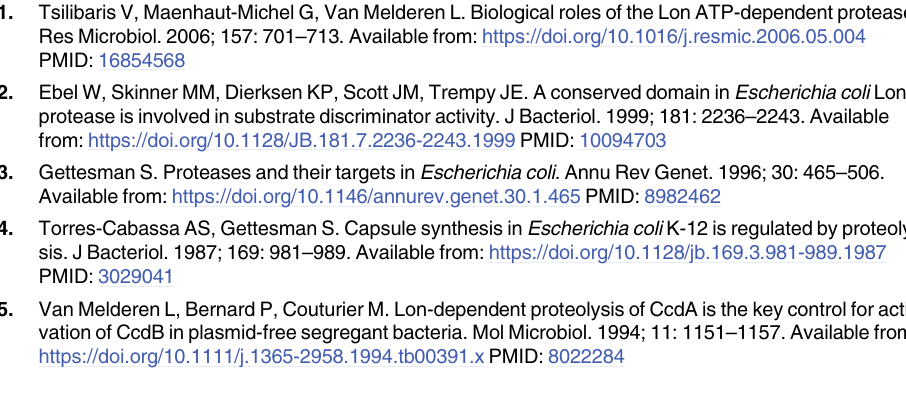
S4 Fig. Oxalate biosynthetic component activity (units per CFU). The letters (a, b, and c) above each mean represent significant differences based on a one-way analysis of variance (ANOVA), followed by Tukey’s post-hoc analysis. A value of p < 0.05 indicates significant dif- ferences among strains. S5 Fig. No detection of TofI-HA in the immunoprecipitated sample using an anti-Lon antibody. Strain S2HA carrying the TofI-HA clone, pTOFI6, was used to determine interac- tion between Lon and TofI. S6 Fig. Similarities among ATP-dependent Lon proteases of B . glumae , Pseudomonas aeru- ginosa , Pseudomonas putida , Escherichia coli , and Agrobacterium tumefaciens . Comparison between ATP-dependent Lon proteases of B . glumae BGR1 (bglu_1g13520), P . aeruginosa PAO1 (AAG05192.1), P . putida KT2440 (AAN67065.1), E . coli K-12 substr. MG1655